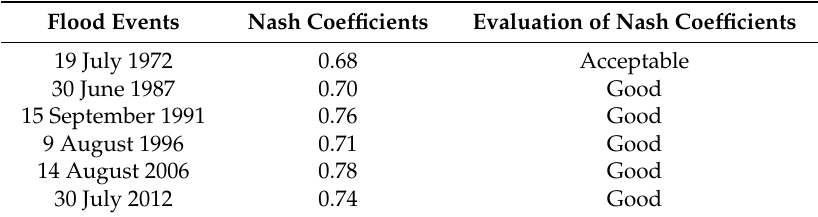
Table 10. The Nash coefficients of flood events.